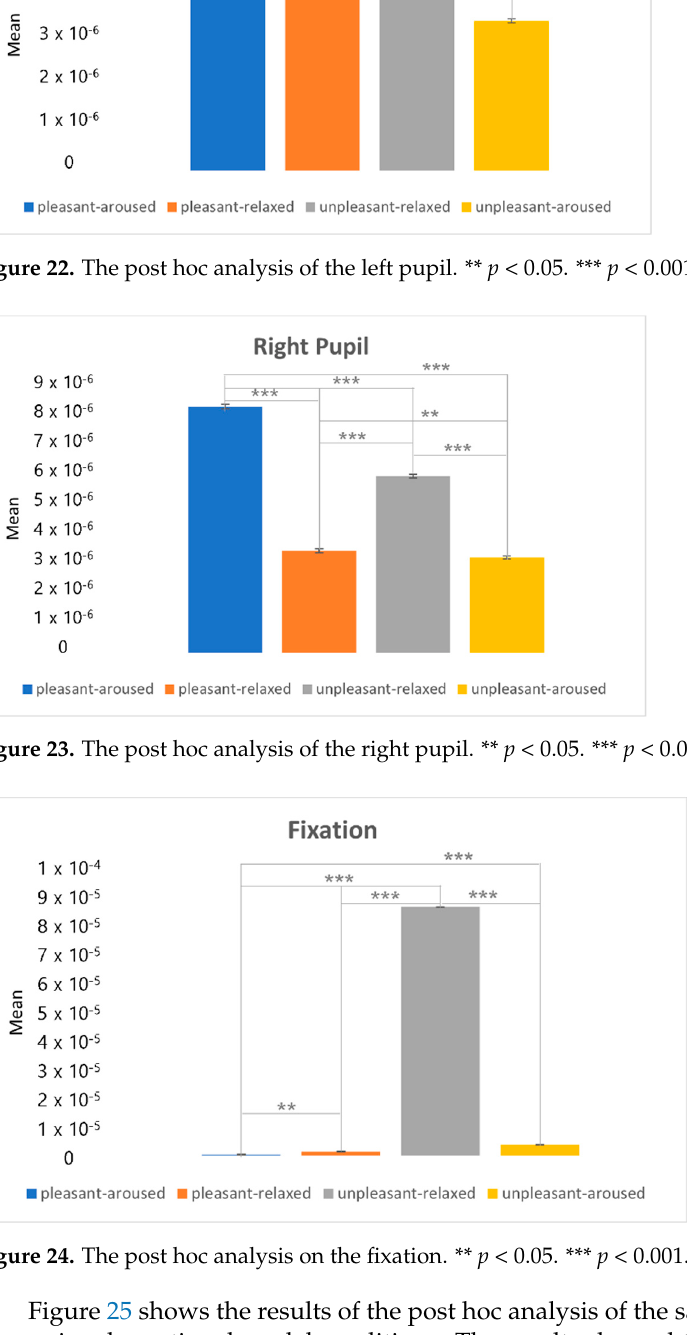
Figure 25. The post hoc analysis on the saccade. *** p < 0.001. 5. Conclusions and Discussion This study aimed to understand the relationship between brain wave connectivity and eye movement characteristic values using a two-dimensional emotional model. We divided brainwave connectivity into three distinct groups: long-distance occipital–frontal connectivity, long-distance prefrontal connectivity between the prefrontal lobe and tem- poral lobe, parietal lobe, and central lobe, and short-distance connectivity including the characteristic relationships between the frontal lobe–temporal lobe, frontal lobe-central lobe, temporal–parietal lobe, and parietal lobe–central. Then, through unsupervised learn- ing of these three eigenvalues, the emotional response was divided into emotional and non-emotional states in real time using K-means analysis. The two states were used to extract the feature values of the eye movements. We analyzed the relationship between eye movements and brain wave connectivity using statistical analyses. The results revealed that the connectivity eigenvalues of the long-distance prefrontal lobe, temporal lobe, parietal lobe, and center are related to cognitive activity involving high valence. The prefrontal lobe occupies two-thirds of the human frontal cortex [32] and is responsible for recognition and decision-making, reflecting cognitive judgment from valence responses [33,34]. Specifically, the dorsolateral prefrontal cortex (dlPFC) is in- volved with working memory [35], decision making [36], and executive attention [37]. However, most recently, Nejati et al. [32] found that the role of dlPFC extends to the reg- ulation of the valence of emotional experiences. Second, the saccade correlated with long- distance occipital-frontal connectivity. After making a judgment, the frontal lobe provides instructions to the occipital lobe, which moves the eye. Electrical stimulation of several